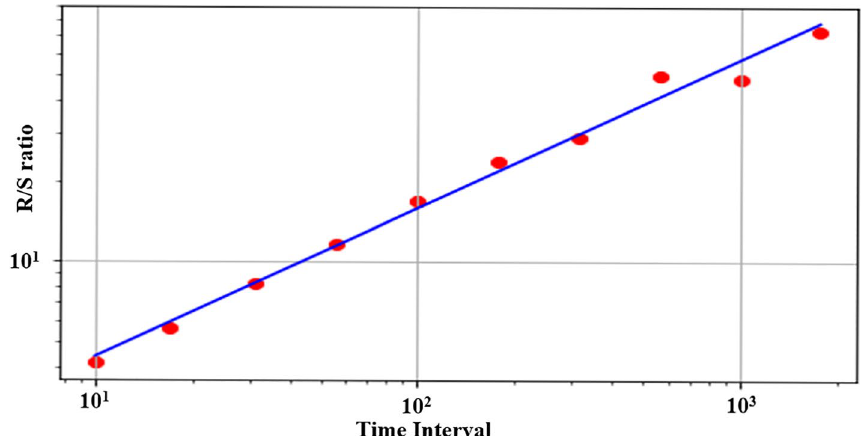
Fig. 6 Scatter plot shows AUD/USD currency connection with 1-day intervals and its trend line, with {R/St} to the values of